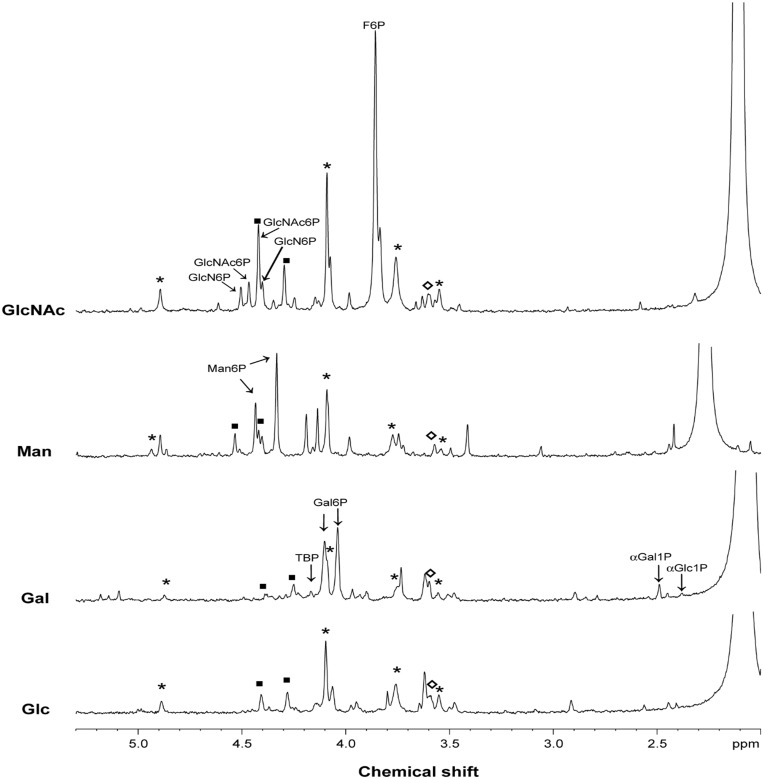
Phosphomonoester region of 31P-NMR spectra of ethanol extracts obtained in late-exponential cells of S. pneumoniae D39 grown in CDM with galactose (Gal), mannose (Man) or N-acetylglucosamine (GlcNAc).Ethanol extracts of glucose (Glc) grown cells were used as control. The glycolytic intermediates fructose 1,6-biphosphate (FBP), glucose 6-phosphate (G6P) and 3-phosphoglycerate (3-PGA) were firmly assigned. Abbreviations: αGal1P, α-galactose 1-phosphate; αGlc1P, α-glucose 1-phosphate; TBP, tagatose 1,6-diphosphate; Gal6P, galactose 6-phosphate; Man6P, mannose 6-phosphate; GlcN6P, glucosamine 6-phosphate; GlcNAc6P, N-acetylglucosamine 6-phosphate and F6P, fructose 6-phosphate. Identification of phosphorylated intermediates was performed by spiking the ethanol extracts with pure compounds. Symbols: (asterisk) FBP, (closed square) G6P, (open diamond) 3-PGA.